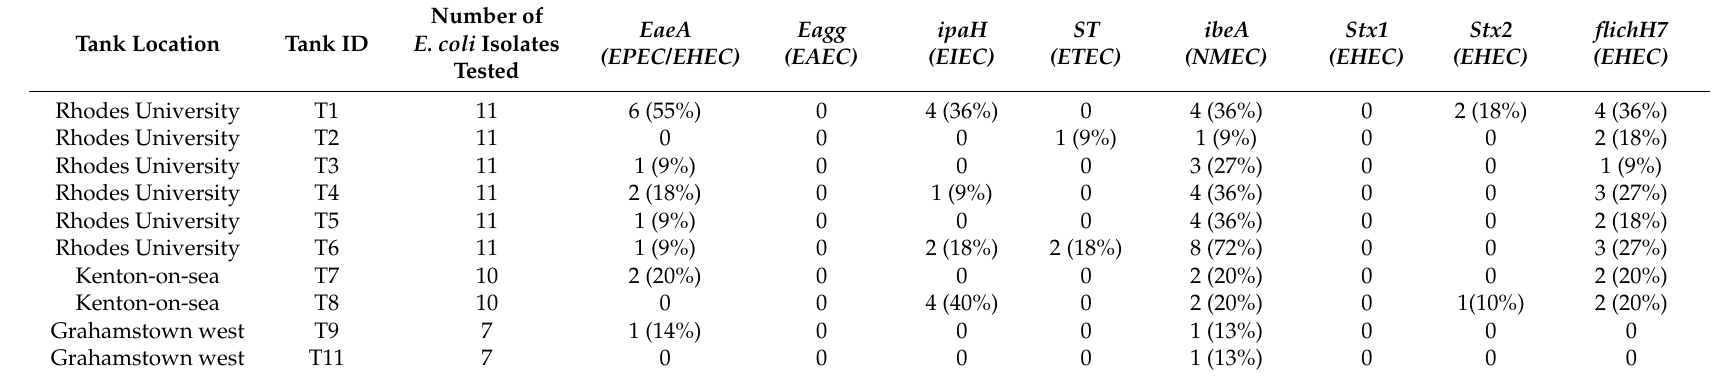
Table 3. Number of virulence genes detected from rainwater-harvesting